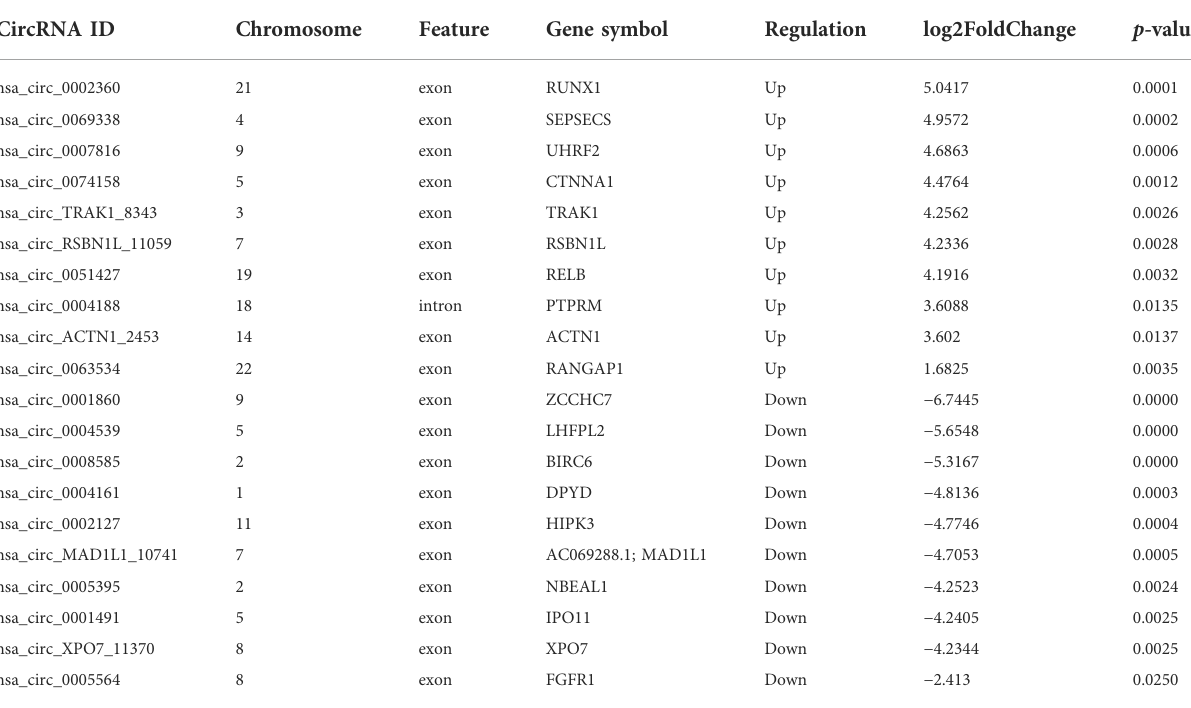
TABLE 1 The 20 DE circRNAs of the RNA-seq dataset.